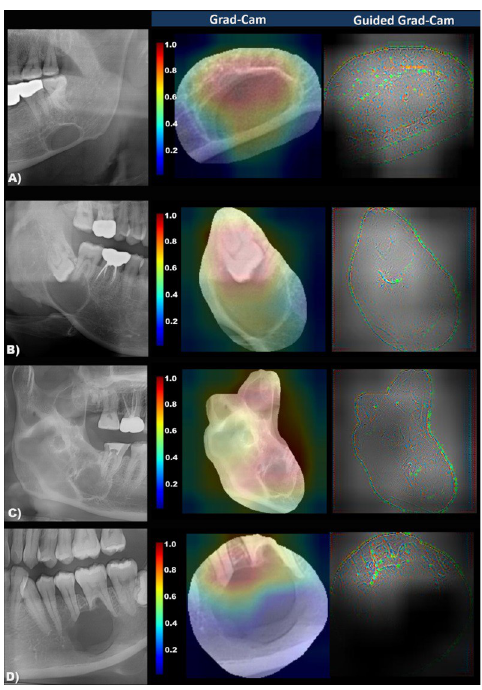
Fig 5. The panoramic image and the importance-weighted visualization image of classification criteria (Grad-Cam and Guided Grad-Cam) in Stafne’s bone cavity (A), dentigerous cyst (B), odontogenic keratocyst, (C), and ameloblastoma (D). Note that the important degree of imaging features for Stafne’s bone cavity classification is color- coded from red (highly-weighted) to blue (less-weighted). The model visualizes the empty internal area and mandibular inferior cortex in Stafne’s bone cavity, while tooth-bearing, multiple locules, and root resorption are well recognized in cysts and tumors.